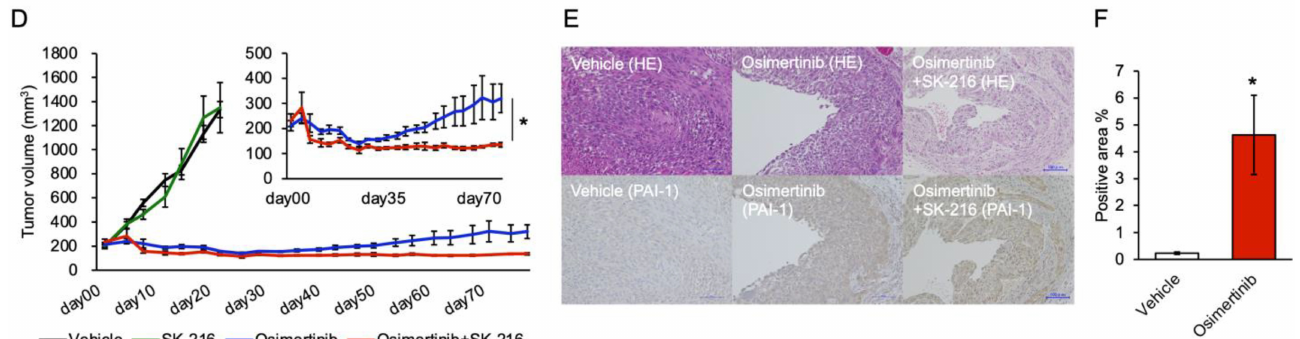
Figure 5. PAI-1 inhibition limited tolerance to osimertinib and regrowth in the subcutaneous tumor model. ( A ) H1975 cell tumor bearing mice were treated with vehicle (vehicle group) or osimertinib (osimertinib group), as described in the Methods Section (n = 6 each). Tumor volumes were measured over time from the start of treatment. Mean tumor volumes are shown with standard error bars; * p < 0.05 compared to the vehicle group (Student’s t -test). Representative images of tumor specimens stained with antibodies against human PAI-1 via immunohistochemistry. ( B ) The upper row is arranged with hematoxylin and eosin (HE) staining, and the lower row is arranged with PAI-1 immunostaining images. Tumors of the vehicle group and osimertinib group are shown; bar: 50 µ m. ( C ) The proportion of PAI-1-positive areas between tumors of the vehicle group and osimertinib group. Data represent the mean values of six samples with standard error bars; * p < 0.05 compared to vehicle group (Student’s t -test). ( D ) H1975 cell tumor bearing mice were treated with vehicle (vehicle group), SK-216 (SK-216 group), osimertinib (osimertinib group), and osimertinib with SK-216 (osimertinib + SK-216 group), as described in the Methods Section (n = 8 each). A graph of the osimertinib group and osimertinib + SK-216 group is also shown in the upper right corner. Tumor volumes were measured over time from the start of treatment. Mean tumor volumes are shown with standard error bars; * p < 0.05 compared to the osimertinib group (one-way ANOVA with Tukey’s test). ( E ) The upper row is arranged with hematoxylin and eosin (HE) staining, and the lower row is arranged with PAI-1 immunostaining images. Tumors in the vehicle group, osimertinib group, and osimertinib + SK-216 group are shown; bar: 100 µ m. ( F ) The proportion of PAI-1-positive area between tumors in the vehicle group and osimertinib group. Data represent the mean values of eight samples with standard error bars; * p < 0.05 compared with the vehicle group (Student’s t